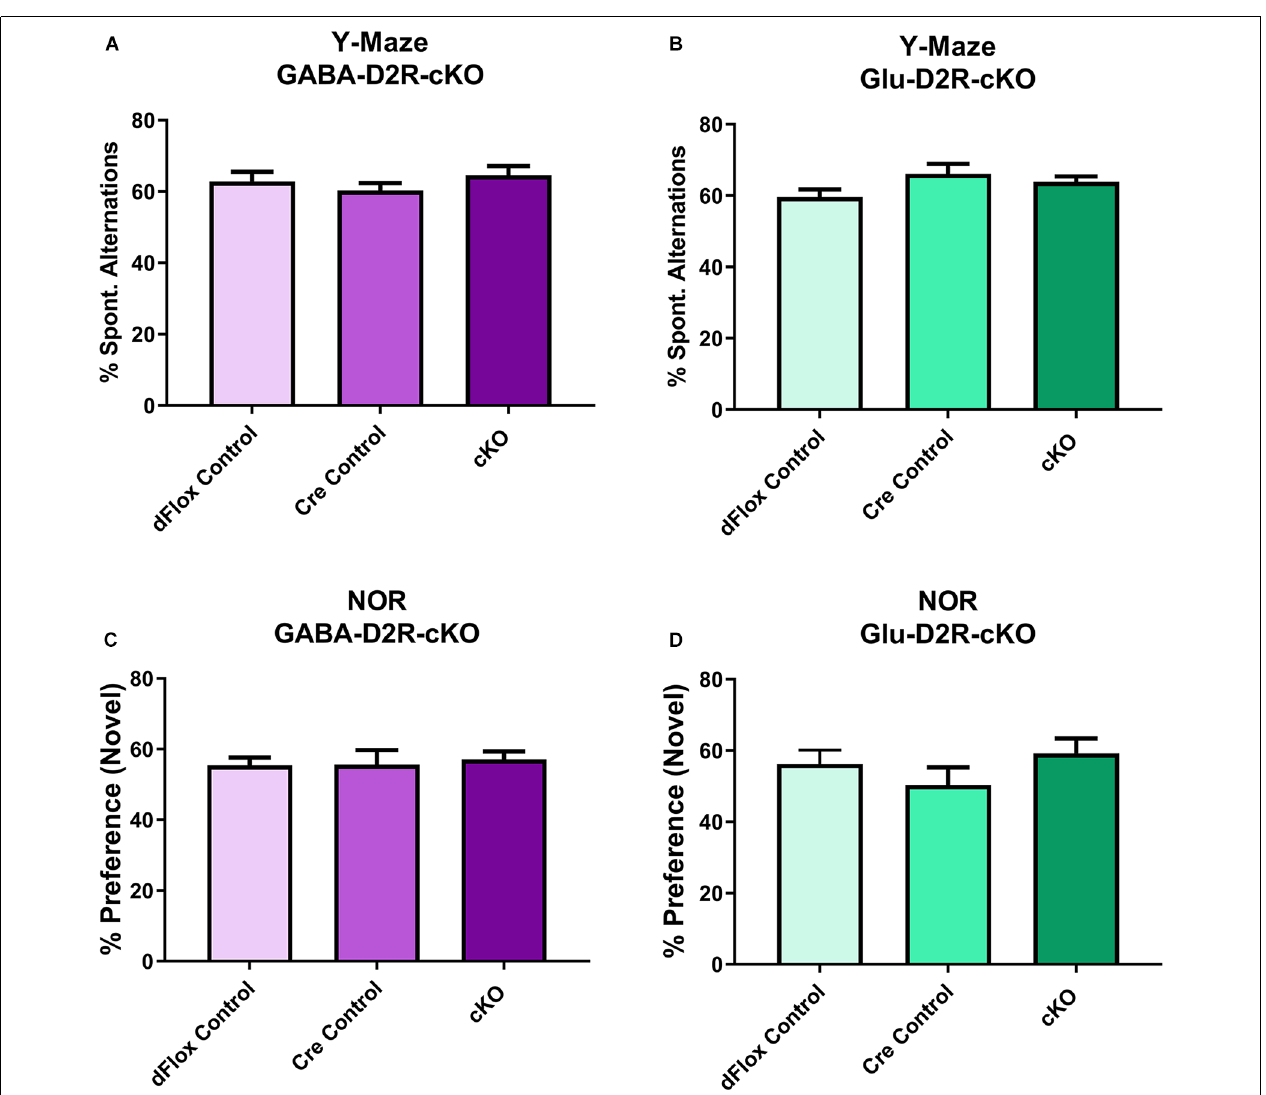
FIGURE 9 | No changes in short-term and working memory in either GABA-D2R-cKO or Glu-D2R-cKO mice. Performance in neither the Y-maze (A,B) nor the NOR test (C,D) resulted in changes in the GABA-D2R-cKO (A,C) or Glu-D2R-cKO mice. N = 8–13/group.